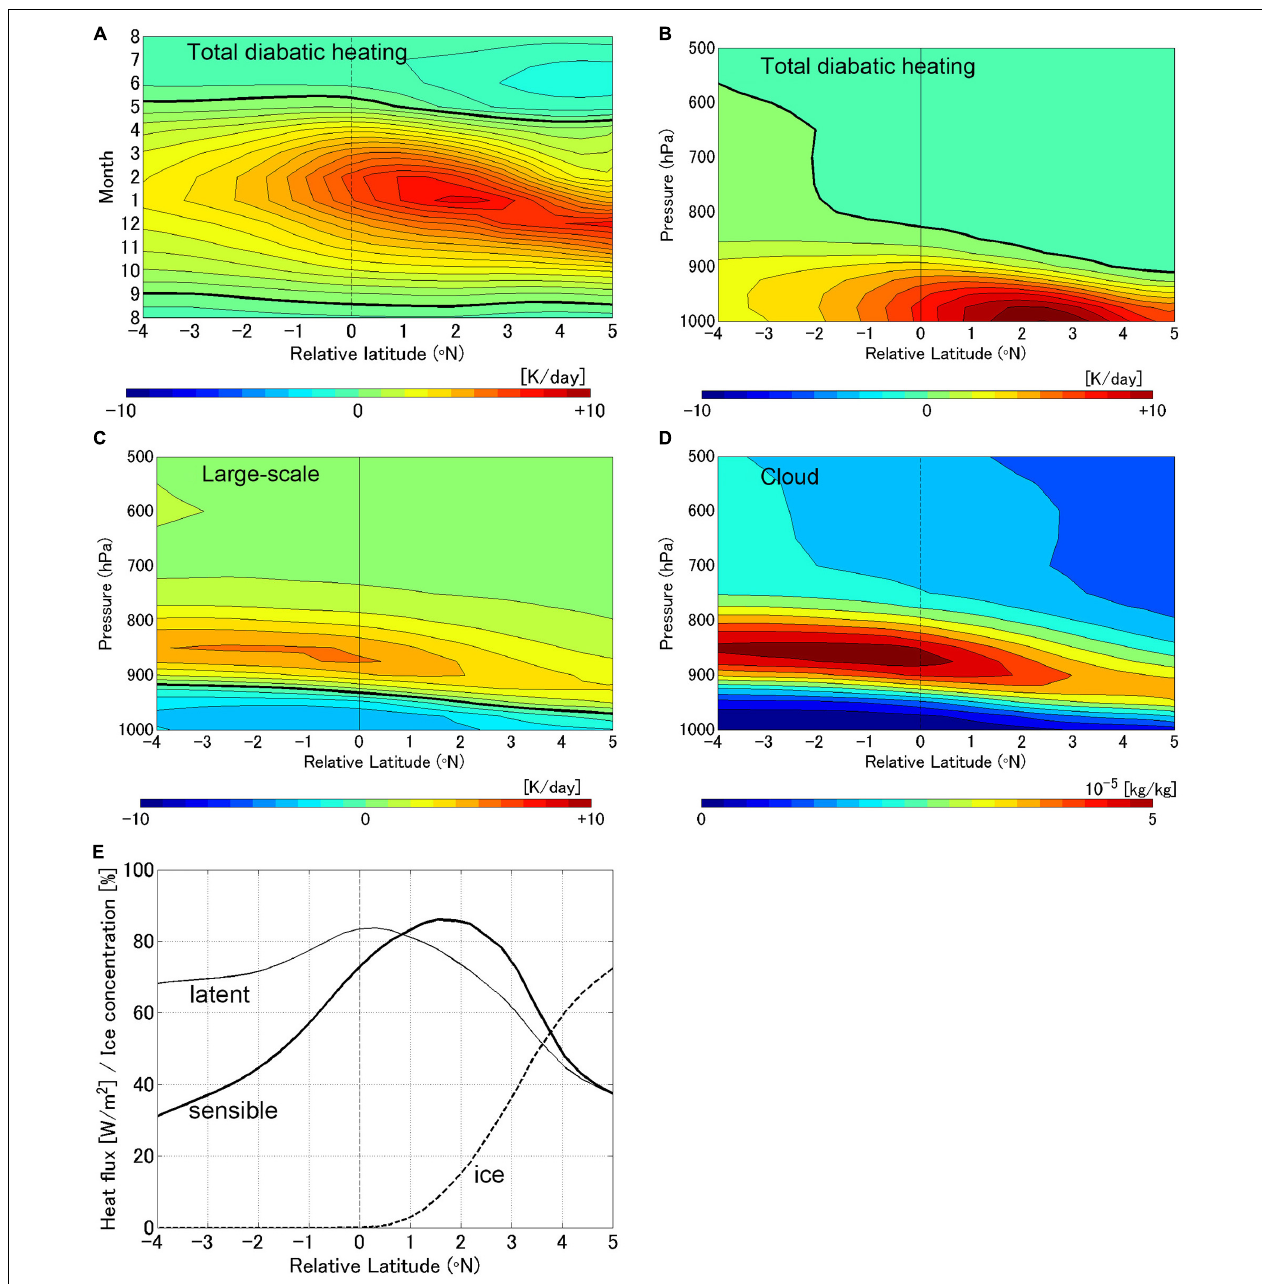
FIGURE 7 | (A) Latitude-time section of total diabatic heating averaged between 900 and 1,000 hPa, and altitude-latitude sections of (B) total diabatic heating, (C) large-scale condensation component, and (D) cloud water mixing ratio over the Bering Sea (black dashed box in Figure 6A ) for January to February. Black bold lines in (A–C) are zero contours. (E) Sensible heat flux (bold line), latent heat flux (thin line), and sea ice concentration (dashed line) for January to